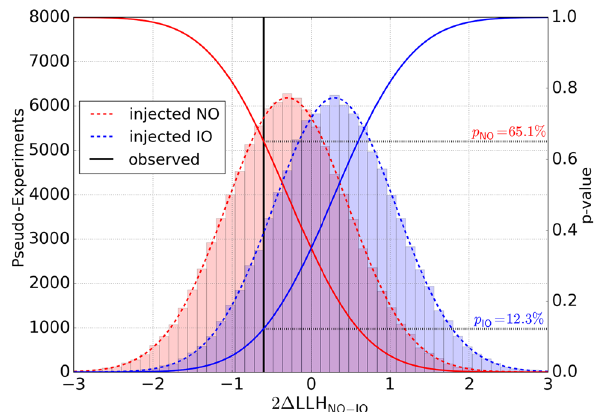
Fig. 6 Sketch of the frequentist method, using idealized distributions to illustrate the concepts. The red (blue) distribution will be derived from from PTs assuming the H NO ( H IO ) hypothesis. The black vertical line represents a hypothetically observed value of (cid:4) LLH NO − IO . The resulting p -values (right, vertical axis) for the hypotheses are derived from the cumulative density distributions, marked as red (blue) solid lines for NO (IO)